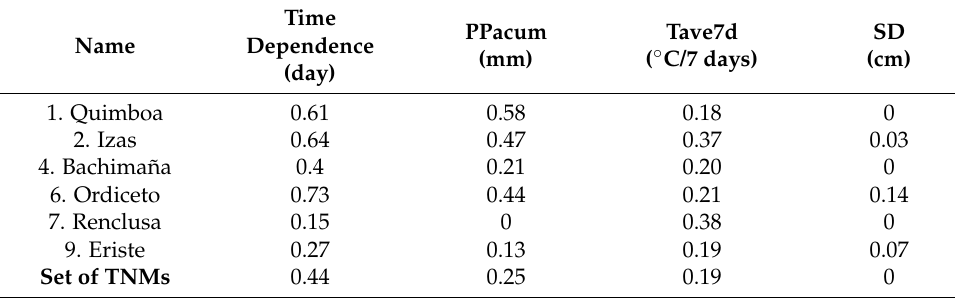
Table 8. SDEN correlation coefficients (R 2 ) for TNM selected sites.